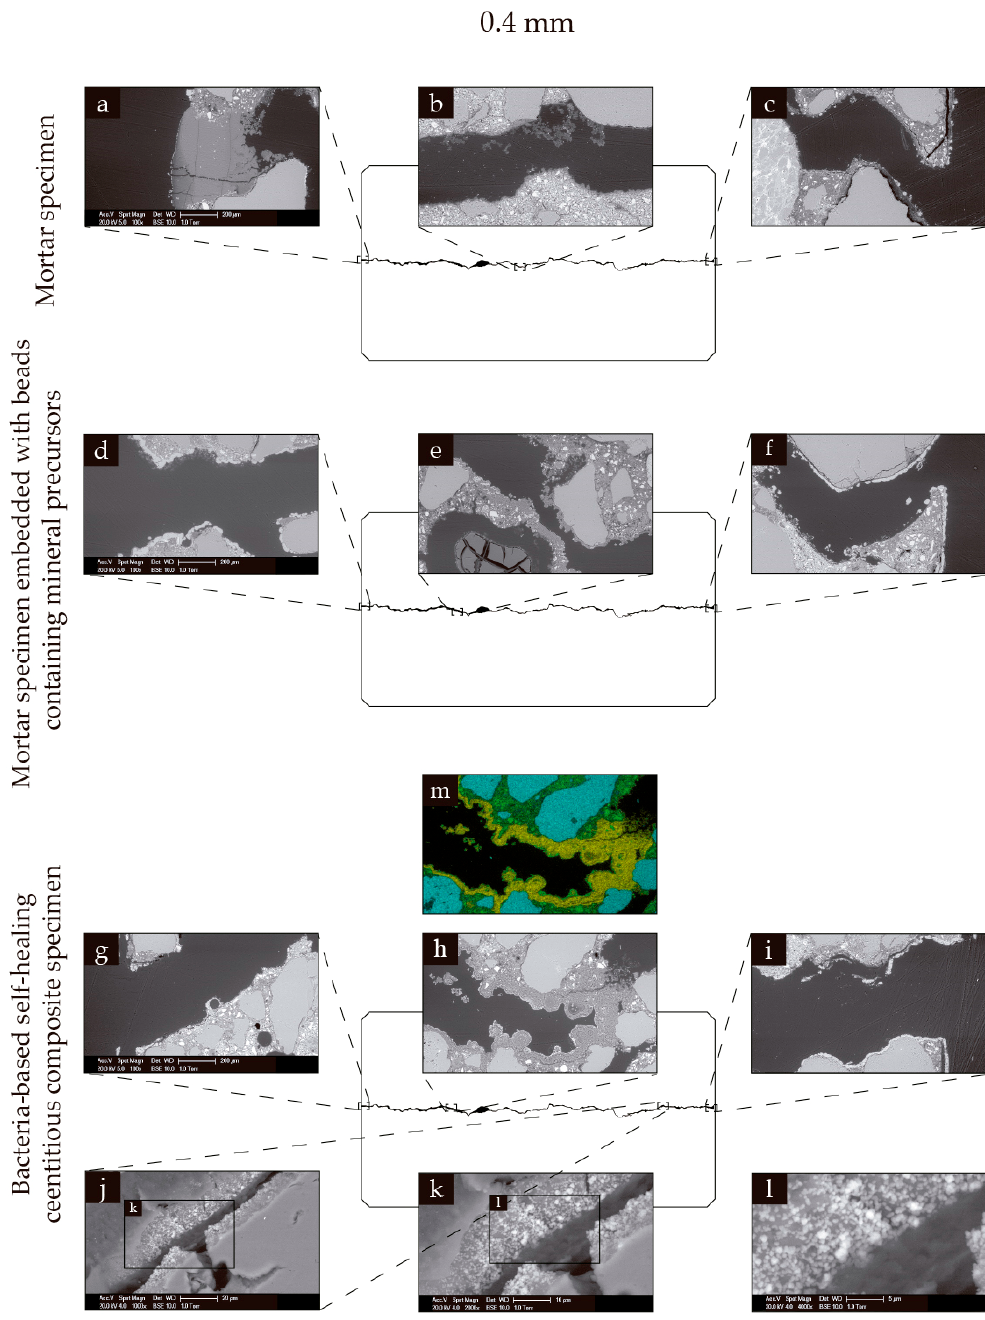
Figure 6. Environmental scanning electron microscopy (ESEM) and energy dispersive spectroscopy (EDS) images of specimens with 0.4 mm wide cracks. ( a – c ) ESEM images of a mortar specimen following 56 days of submersion in seawater at 8 °C: ( a ) a crack mouth; ( b ) an area towards the center of the crack; and ( c ) the other crack mouth. ( d – f ) ESEM images of a mortar specimen incorporated with beads containing mineral precursor compounds after 56 days of submersion in seawater at 8 °C: ( d ) a crack mouth; ( e ) an area towards the center of the crack; and ( f ) the other crack mouth. ( g – l ) ESEM images of a bacteria ‐ based self ‐ healing cementitious composite specimen following 56 days of submersion in seawater at 8 °C: ( g ) a crack mouth; ( h ) an area towards the centre of the crack; ( i ) the other crack mouth; ( j ) a section along the crack of a bacteria ‐ based bead; and ( k , l ) successive close ‐ ups of the bead. The EDS elemental map ( m ) corresponding to ESEM image ( h ). Green in the EDS maps represents calcium, yellow represents magnesium, and blue represents silicate.